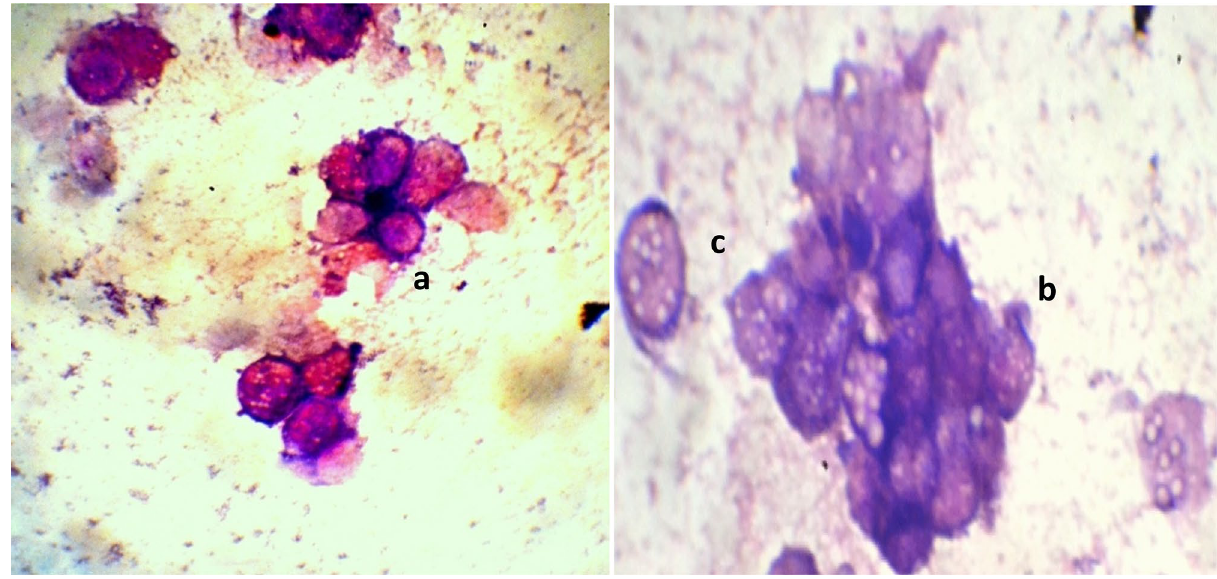
Figure 2. (a) Necrosis (b) Clustering (c) Vacuolization of hemocytes.